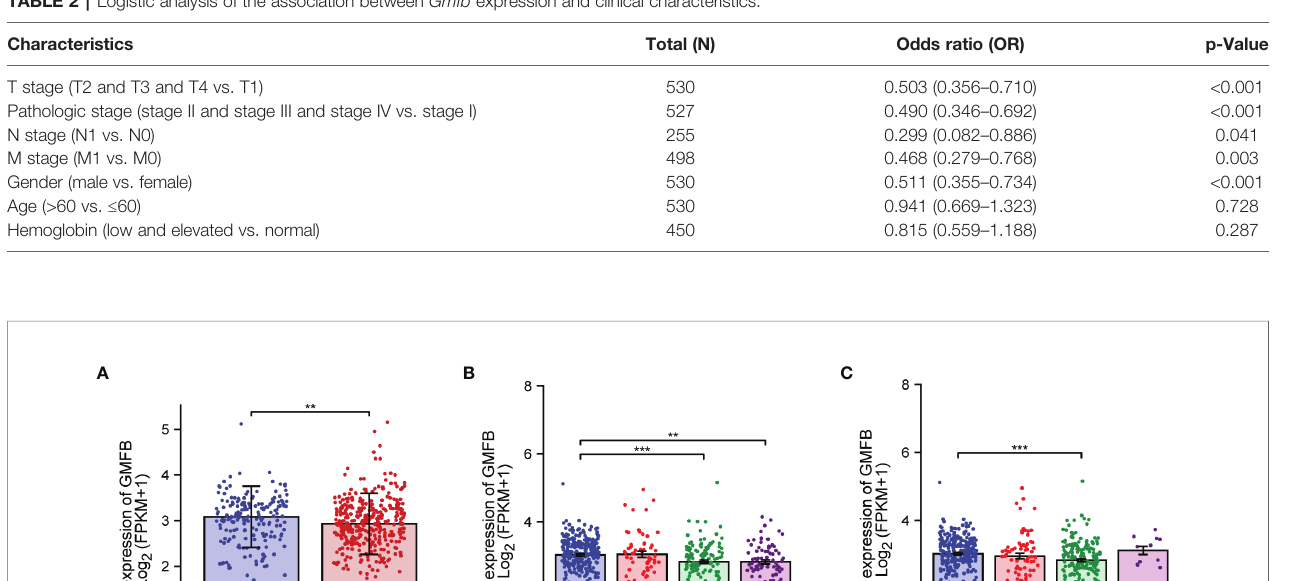
TABLE 2 | Logistic analysis of the association between Gmfb expression and clinical characteristics.